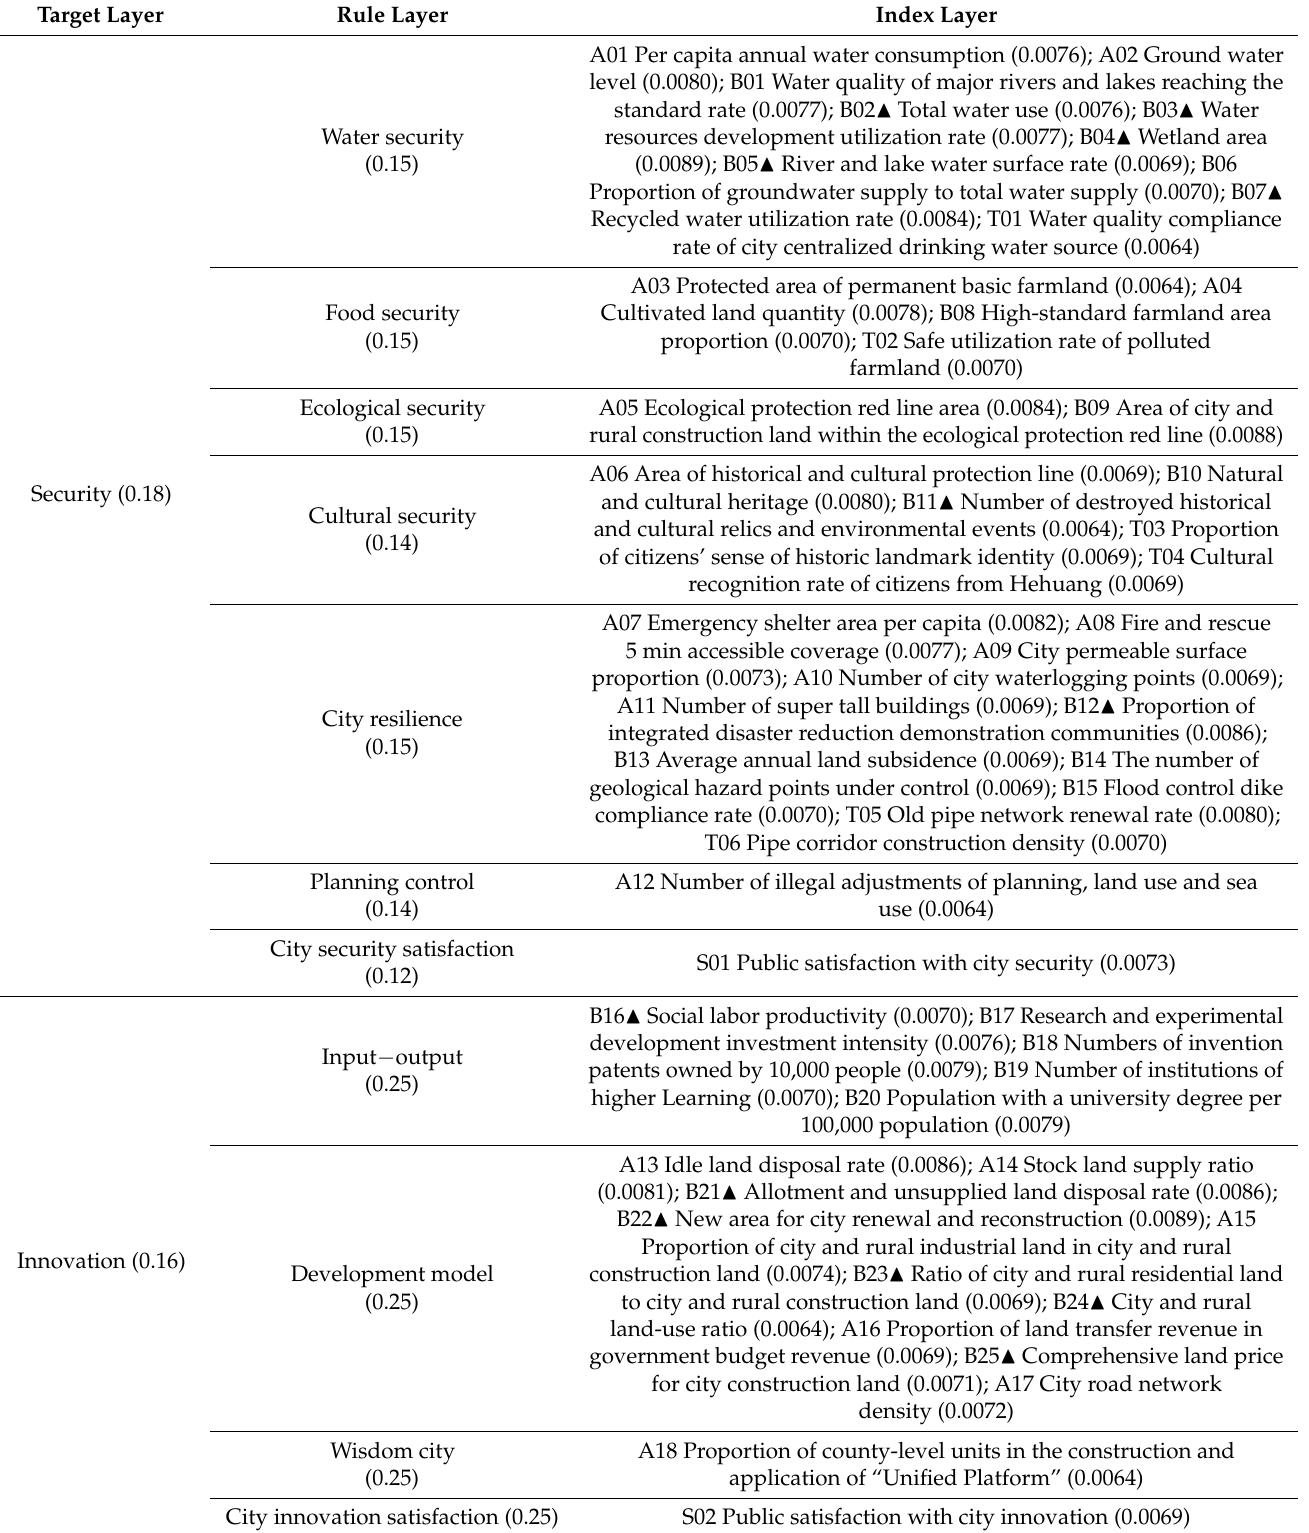
Table 1. City health examination and evaluation index system of territorial spatial planning in Xining